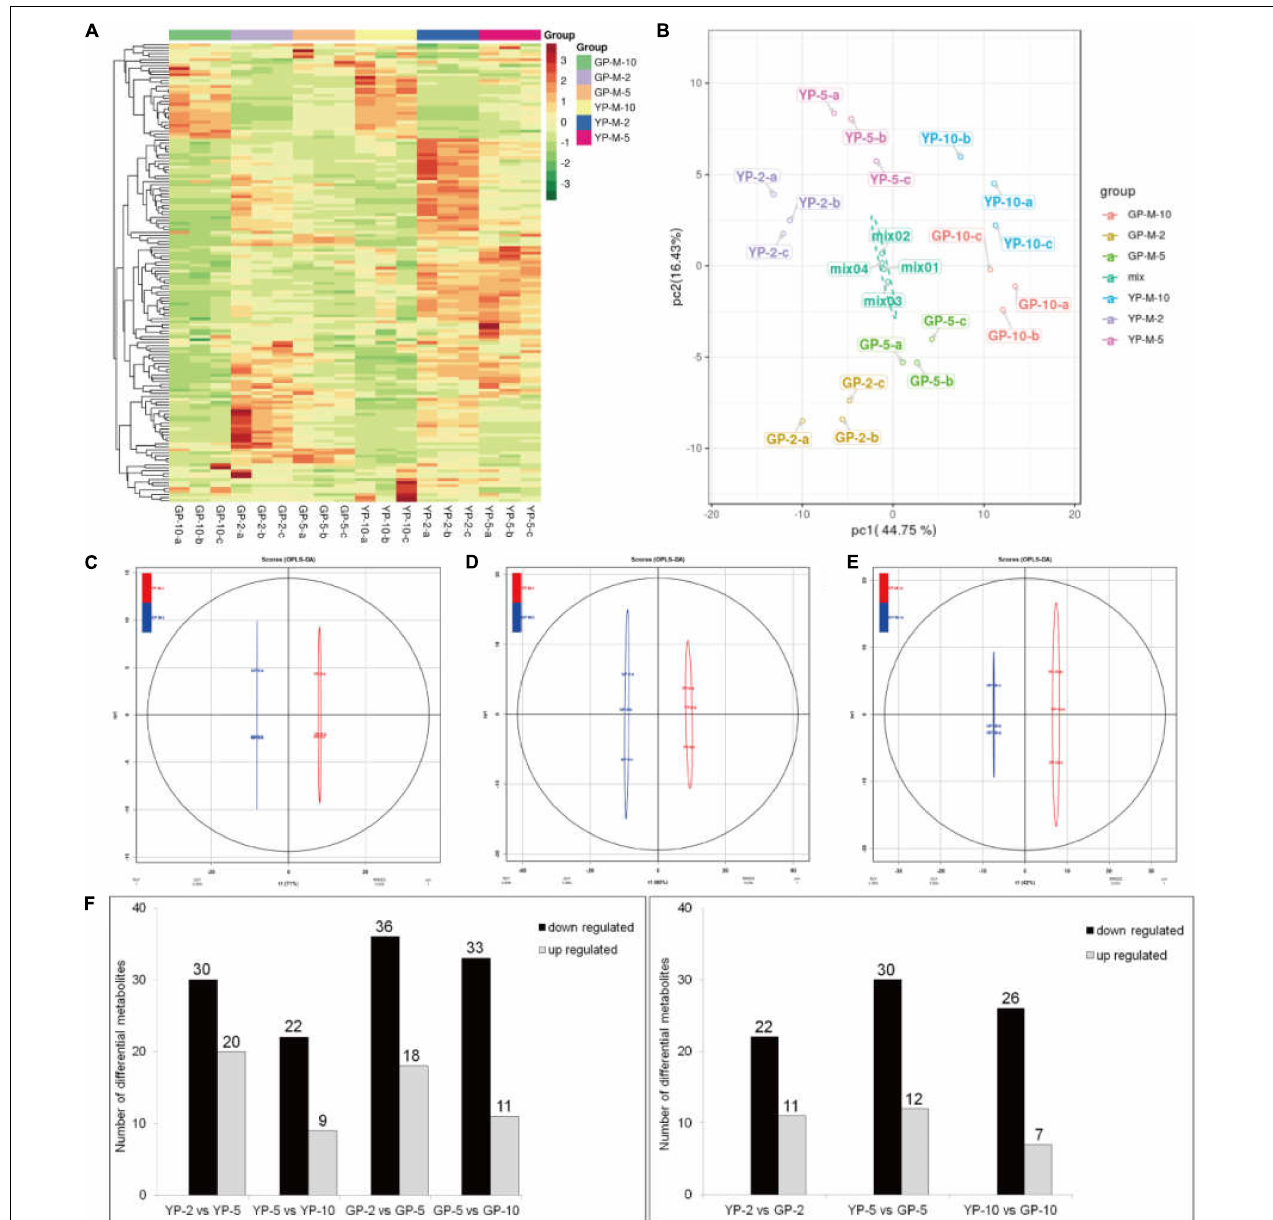
FIGURE 8 | Heat map visualization, PCA, and OPLS-DA of the relative difference in flavonoids metabolites of YP and GP. (A) Heat map of all detected metabolites. The content of each metabolite was normalized to complete linkage hierarchical clustering. Each example is visualized in a single column, and each metabolite is represented by a single row. Red indicates high abundance; green showed low relative content. (B) Score plots for principle components 1 and 2 within and between groups. (C–E) OPLS-DA model plots for YP versus GP at different comparison groups in the same period. (F) The differentially metabolism analysis between wild type and green pod mutant at different comparable